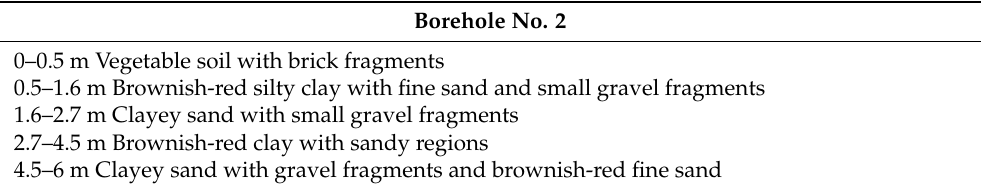
Table 2. Lithologic description for the investigated site based on the second borehole. Borehole No.